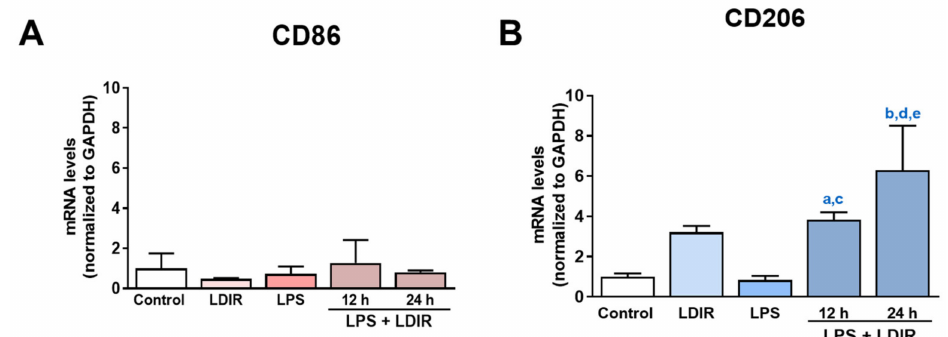
Figure 4. The e ff ects of LDIR exposure on the expressions of M1 / M2 markers in BV-2-stimulated cells. BV-2 cells were treated with LPS at a dose of 20 ng / mL for 24 h then exposed to LDIR (1 Gy / 1 fraction). Cells were harvested at 12 and 24 h after irradiation. ( A , B ) The mRNA levels of M1 microglial marker CD86 and M2 microglial marker CD206 were measured by qRT-PCR. a indicated that comparison of control and LPS + LDIR 12 h ( p < 0.05), b indicated that comparison of control and LPS + LDIR 24 h ( p < 0.001), c indicated that comparison of LPS and LPS + LDIR 12 h ( p < 0.05), d indicated that comparison of LPS and LPS + LDIR 24 h ( p < 0.001), and e indicated that comparison of LDIR and LPS + LDIR 24 h ( p < 0.05). Data are presented as mean ± SD from triplicate experiments.